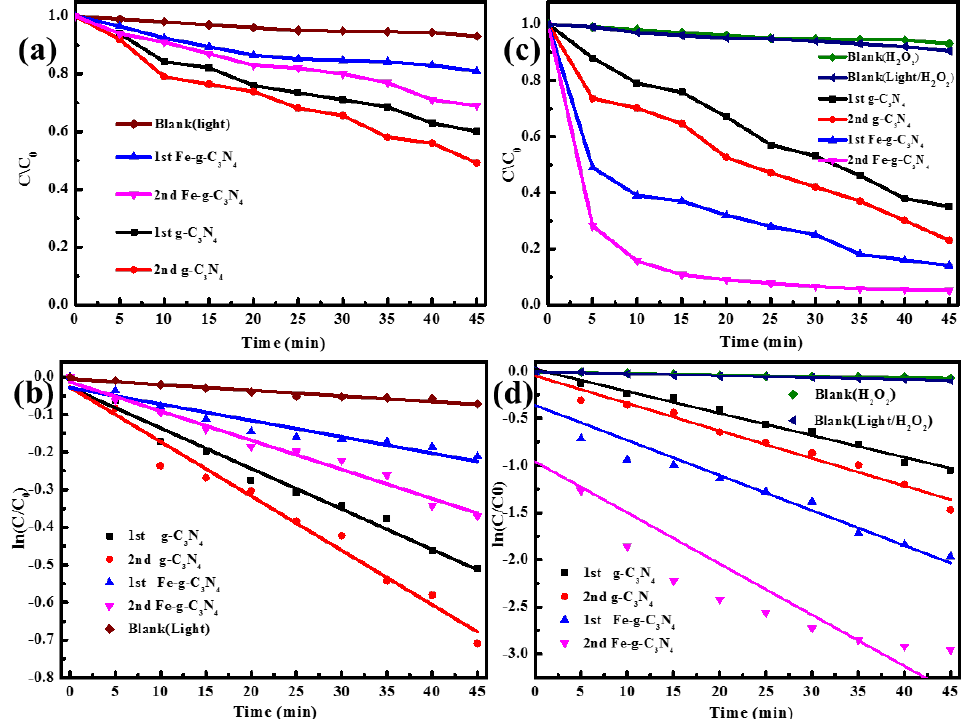
Figure 3. The photocatalysis performance and the pseudo-first-order kinetics fitted curves of RhB ( a , b ); and Fenton-like photocatalysis performance and the pseudo-first-order kinetics fitted curves of RhB ( c , d ).